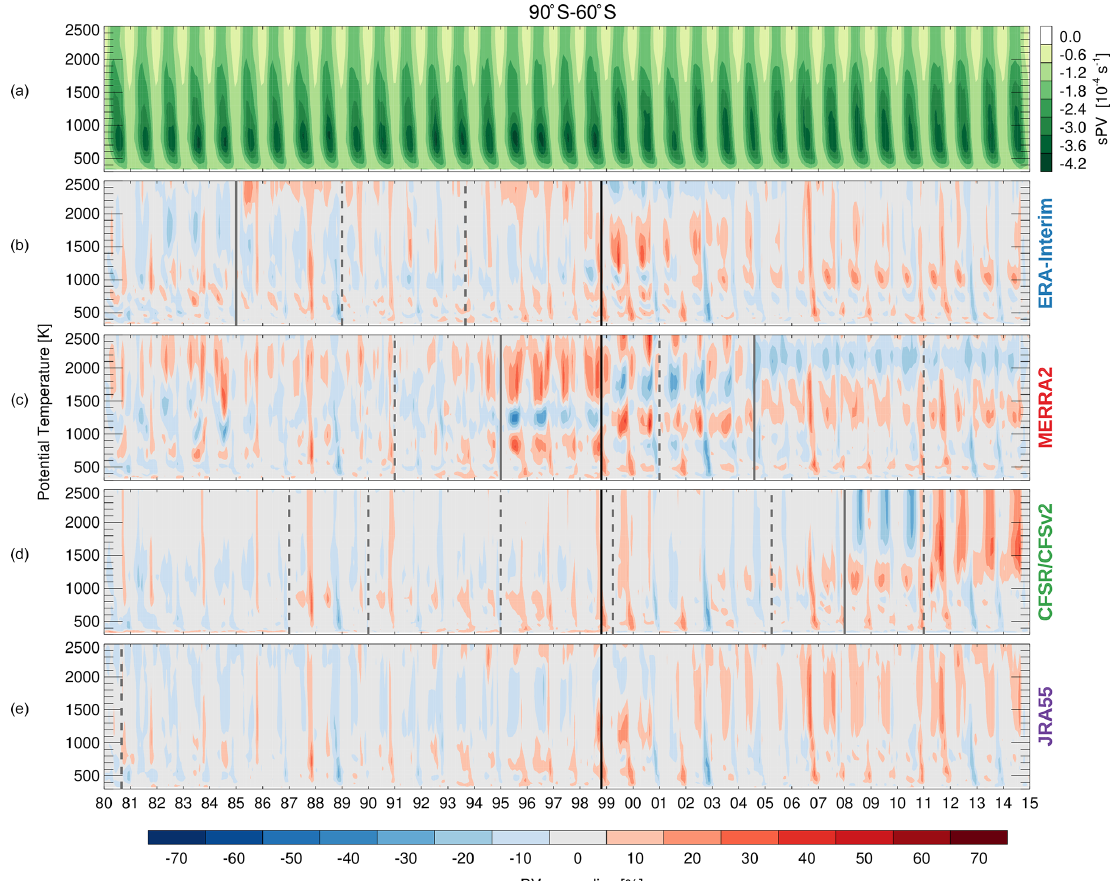
Figure 2. (a) sPV REM time series. (b–e) sPV anomalies with respect to each reanalyses’ own monthly climatological values. Vertical lines show the discontinuities associated with changes in assimilated datasets (solid lines) or different processing streams (dashed lines) as described in the